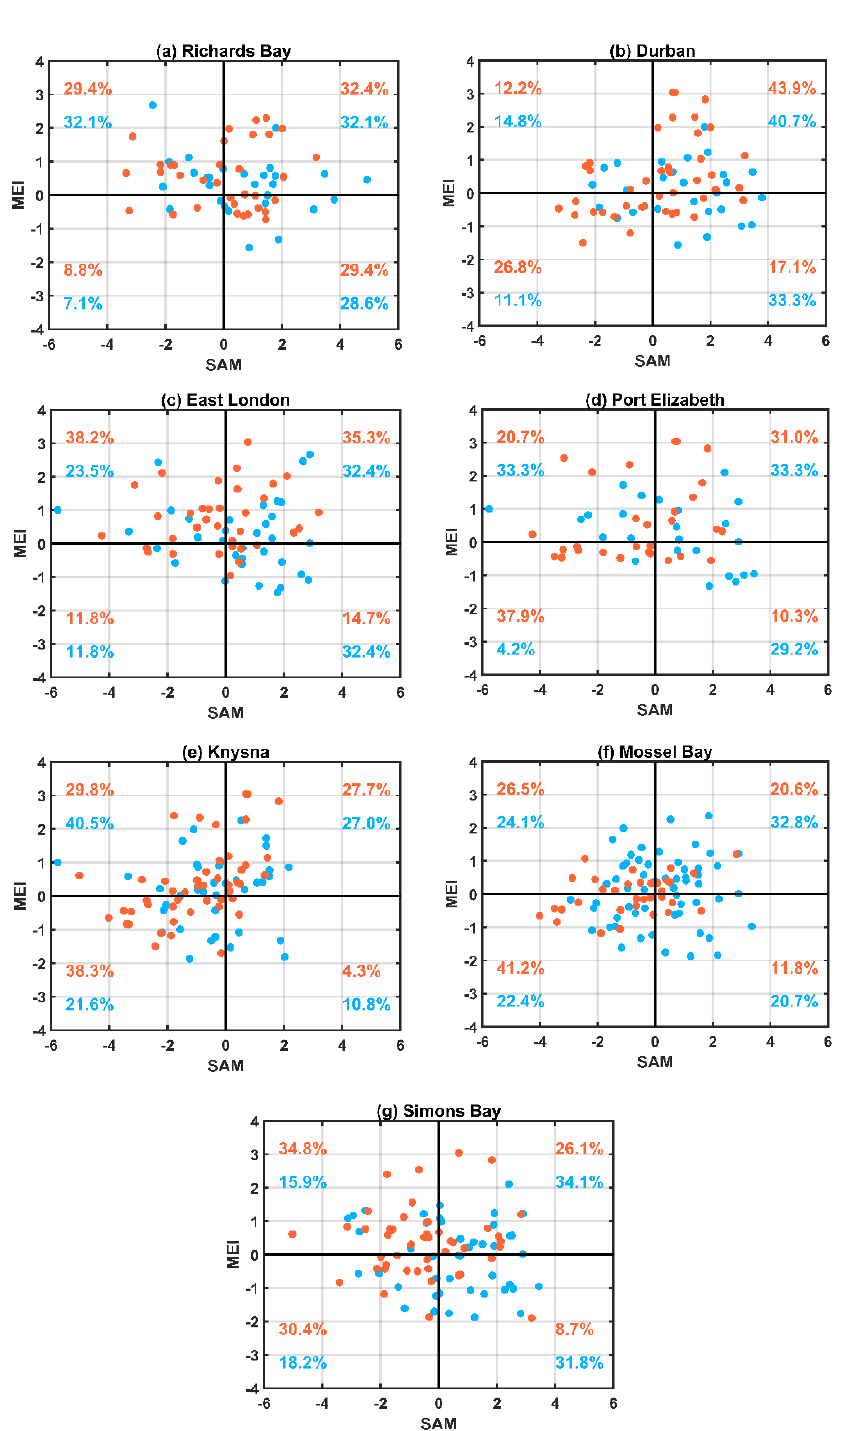
Figure A1. The MEI/DMI combinations in months with higher/lower (in red/blue) sea level than 1.5 standard deviations above/below mean sea level at ( a ) Richards Bay, ( b ) Durban, ( c ) East London, ( d ) Port Elizabeth, ( e ) Knysna, ( f ) Mossel Bay and ( g ) Simons Bay, respectively. The percentages indicate the number of months within a quadrant divided by the total number of the recorded SL months of the paired interactions.